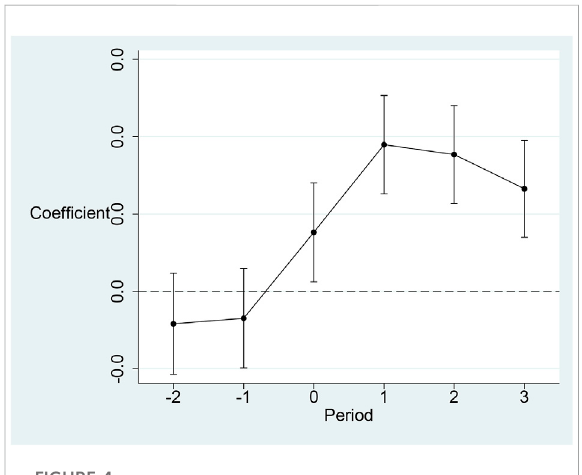
FIGURE 4 ResultsofParallelTrendTest.TheX-axisdenotesthewindow period for ICP implementation. The Y axis represents the regression coef fi cient of ICP implementation. The year before ICP is implemented as the base